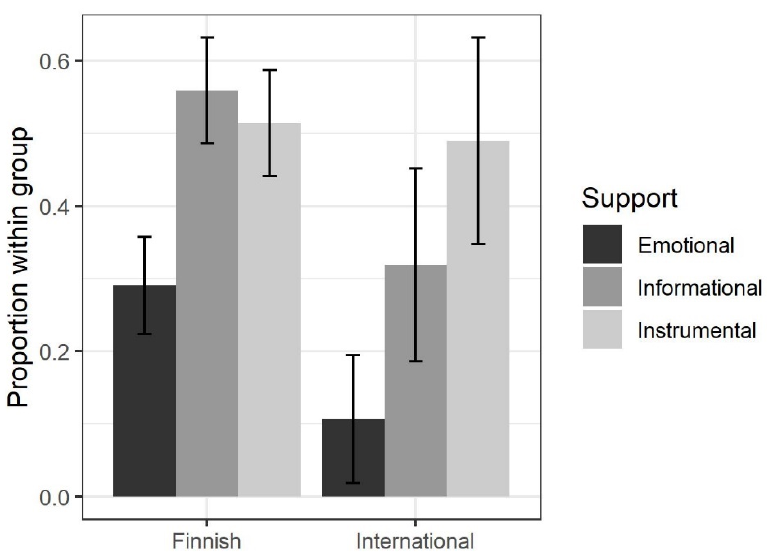
Figure 5. Support needs of Finnish and international students belonging to profile Exhausted